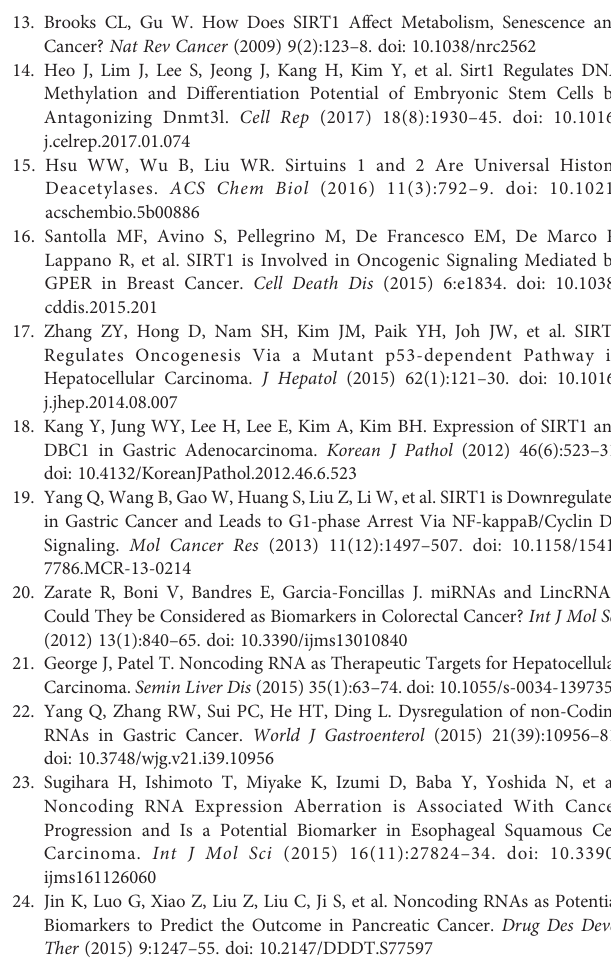
3p inhibitor, miR-1301-3p mimics and their control groups. (E, F) , Quantitative analysis of SIRT1 protein levels in SGC7901 and MGC803 cells transfected with miR-1301-3p inhibitor, miR-1301-3p mimics and their control groups. (G) , Quantitative analysis of SIRT1 protein levels in SGC7901 and MGC803 cells transfected with miR-1301-3p-in+si-NC and miR-1301-3p-in+si-SIRT1. *p < 0.05, **p < 0.01, ***p < 0.001. Supplementary Figure 2 | (A, B) , The protein expression of SIRT1, Cyclin D1, CDK4, c-Myc and P21 in SGC7901 and MGC803 cells transfected with